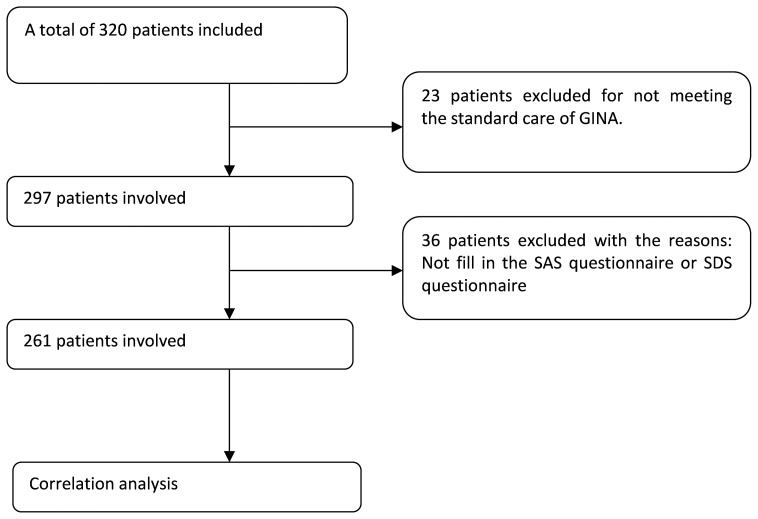
The flowchart of study enrollment.